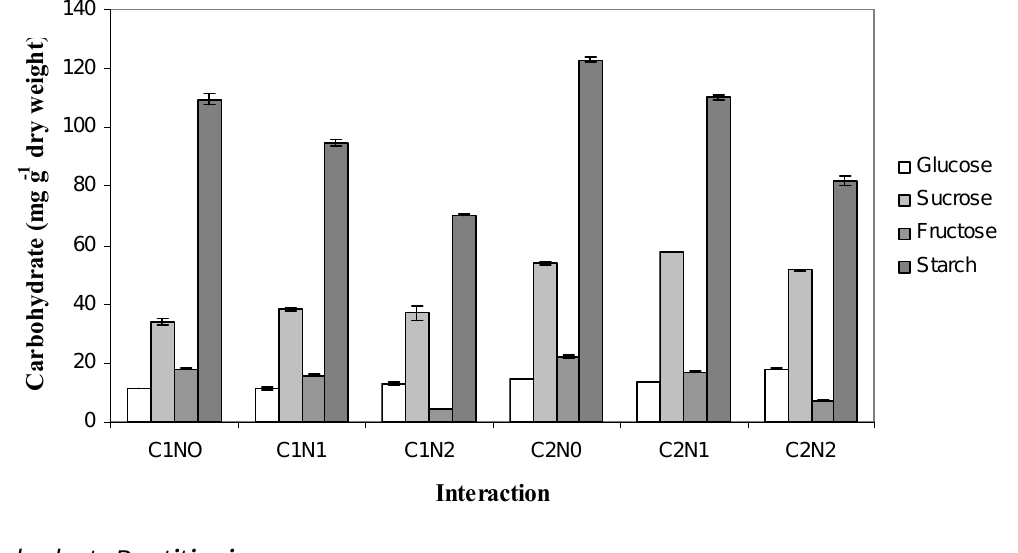
Figure 2. Interaction effects between CO in L. pumila . N = 6. Treatments used were C1N0 = 400 µmol mol − 1 CO C1N1 = 400 µmol mol − 1 CO C2N0 = 1,200 µmol mol − 1 CO 90 kg N Ha − 1 ; C2N2 = 1,200 µmol mol − 1 CO error of differences between means